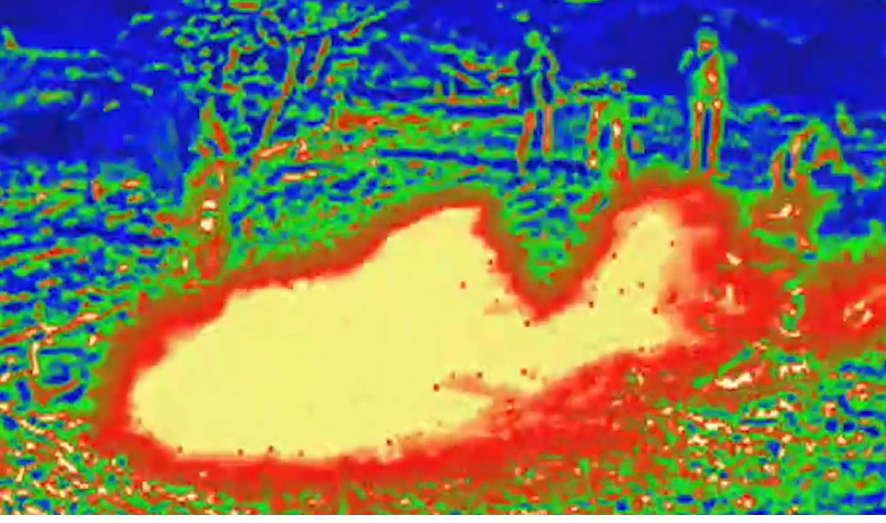
Figure 4. Thermal